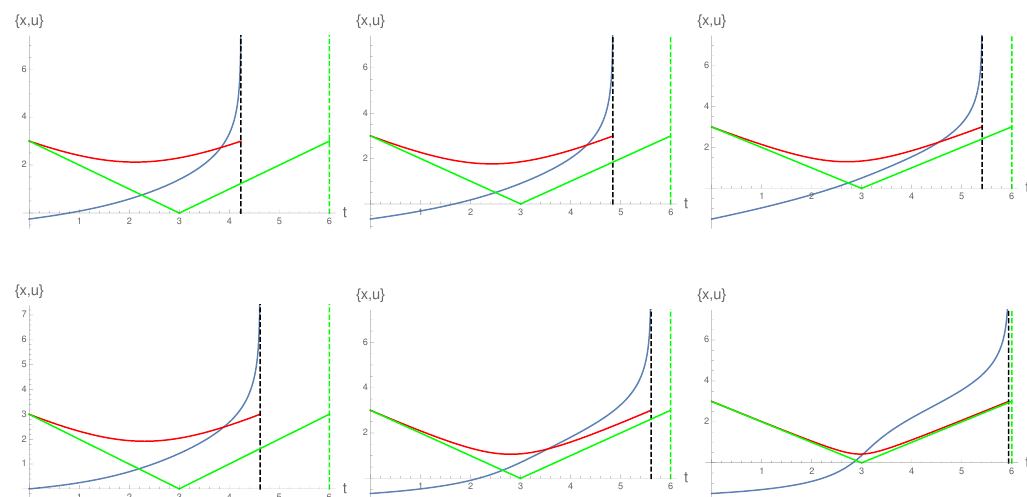
Figure 11. “Bulk geodesics” shown as x ( t ) in blue, u ( t ) in red, and “brane geodesics” shown with u ( t ) in green. Top row: N 5 = K , y 0 = π . Starting point is u 0 = 3 and, from left to right, 4 x 0 ∈ {− 1 , − 2 , − 3 } . x ( t ) diverges after a finite time, which is when the geodesics approach the 4 3 2 conformal boundary of the AdS 5 × S 5 region. The vertical dashed lines show the total time taken to reach the end point. Bottom row: analogous plots for N 5 = 2 K , y 0 = π ; geodesics starting at 4 u 0 = 3 and, from left to right, x 0 ∈ { 0 , − 2 , − 3 } 3 2